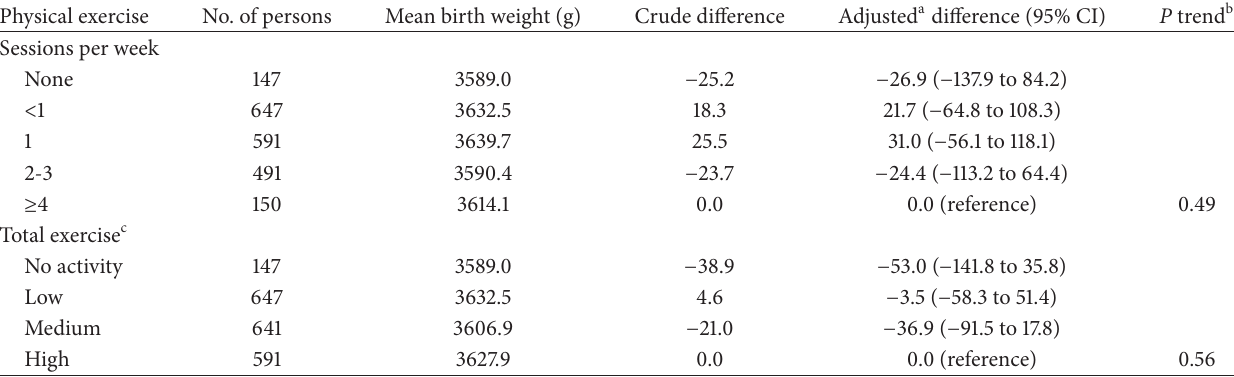
Table 2: Maternal pre-pregnancy leisure time physical exercise and mean offspring birth weight from linear regression analyses.